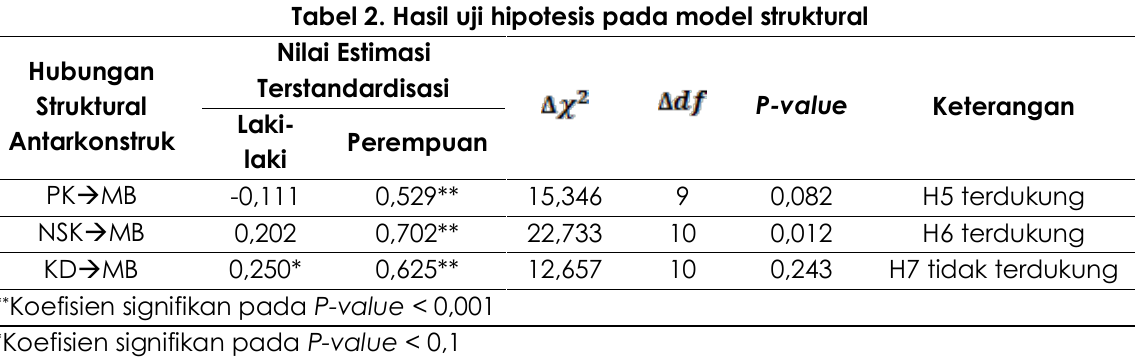
Tabel 2. Hasil uji hipotesis pada model struktural